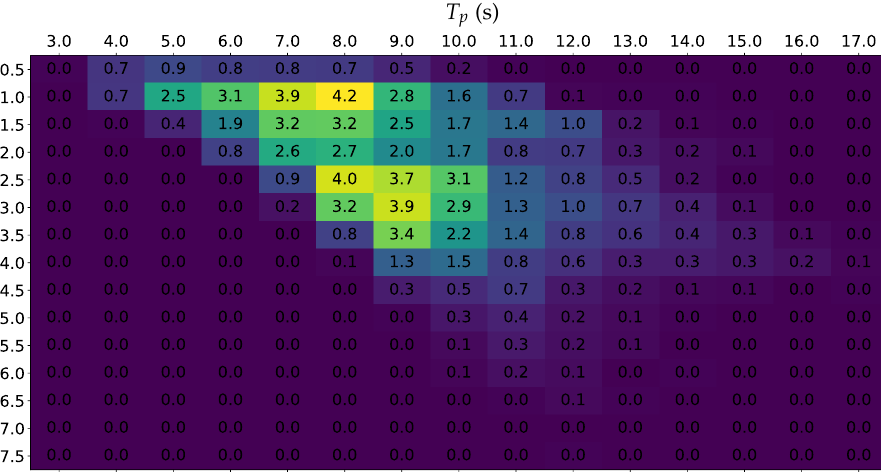
Table 1. Annual probability of occurrence (%) for each sea state at Île d’Yeu